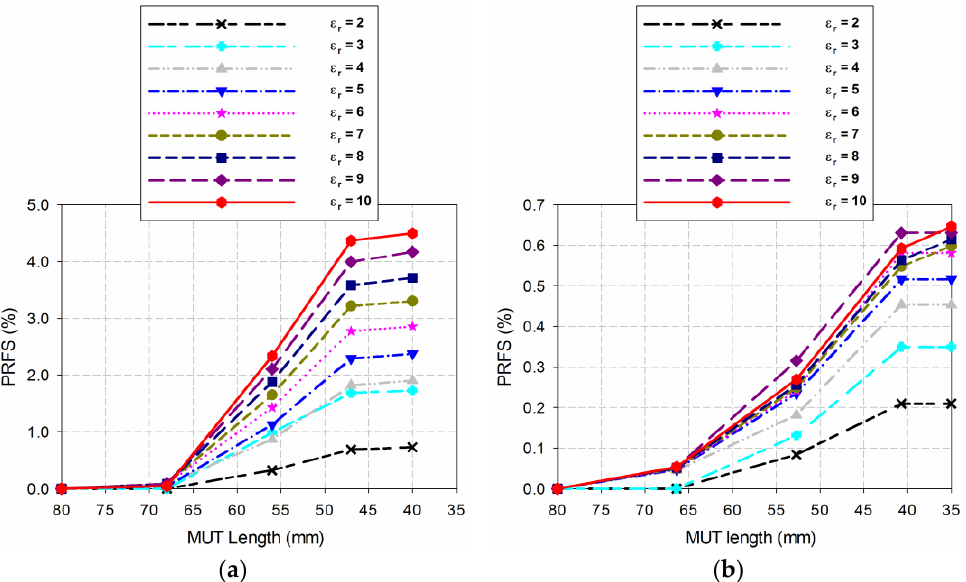
Figure 8. PRFS of the resonant frequency of the conventional and proposed patch antennas when varying the length of the MUT: ( a ) Conventional f r1 ; ( b ) proposed f r1 .